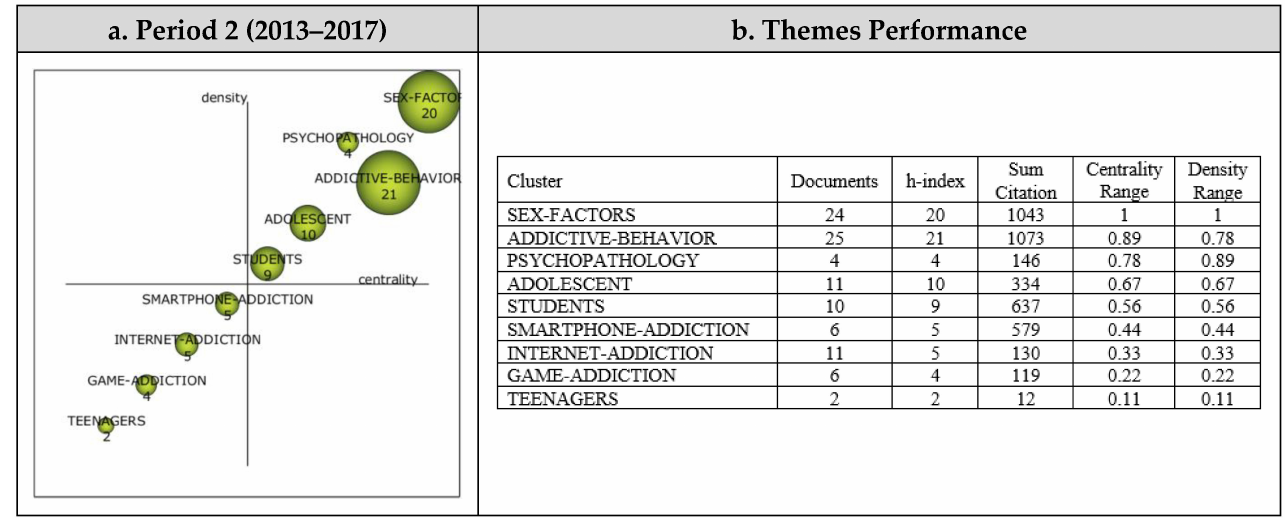
Figure 6. Period 2: ( a ) Strategic diagram and ( b ) performance